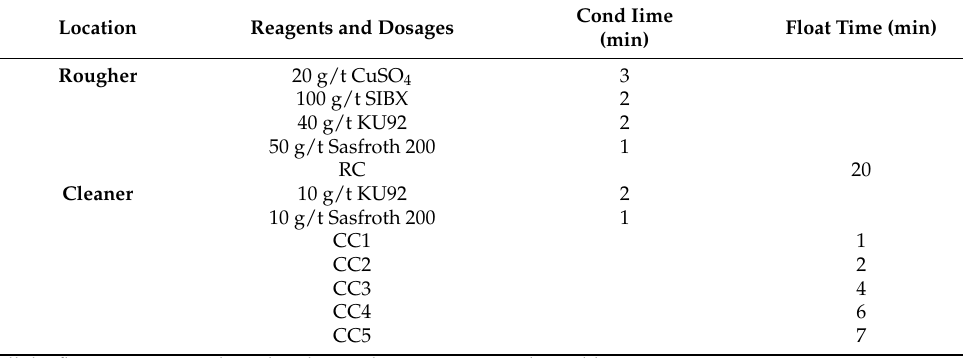
Figure 2. Flowsheet used for cleaner flotation testwork in this study. 1, 3, 7, 13, and 20 represent flotation times. Table 2. Flotation conditions used for cleaner flotation testwork in this study.